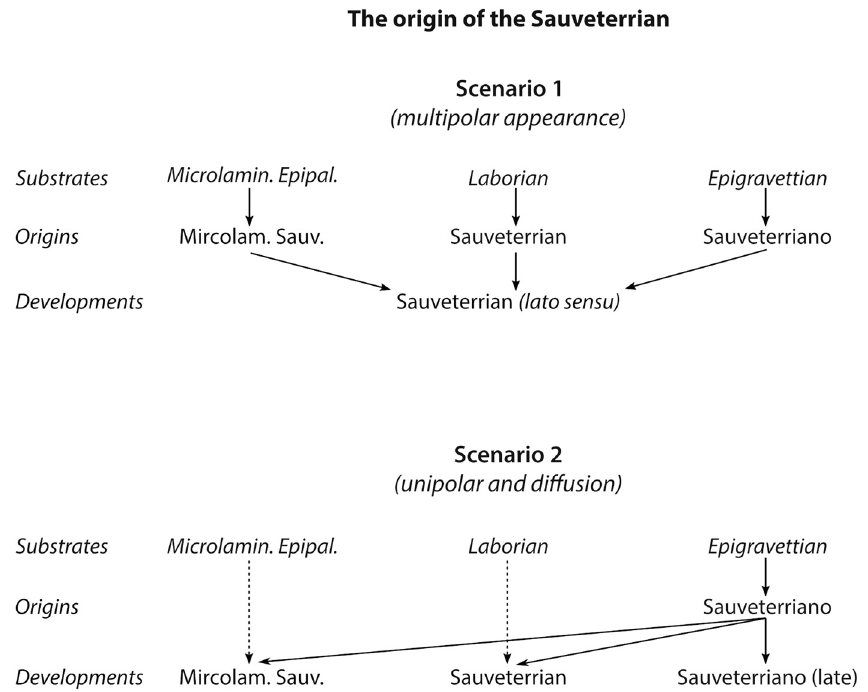
Figure 5: Possible scenarios of the appearance process of the Sauveterrian technocomplex.